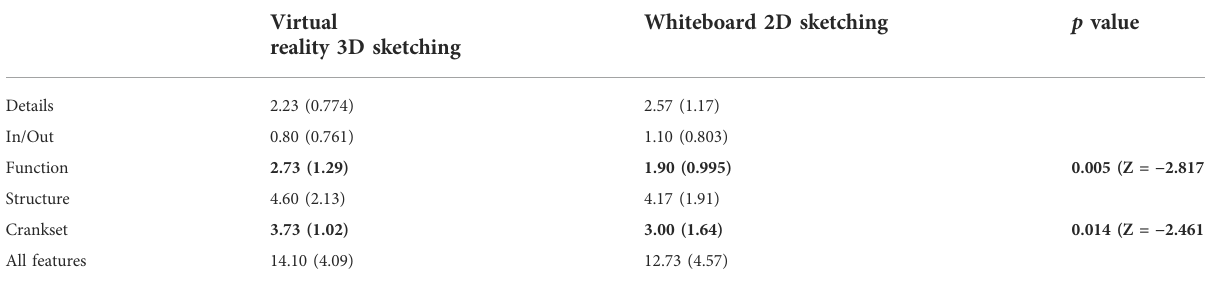
TABLE5Meansandstandarddeviations(betweenbrackets)forthenumberoffeaturesforthesecondphaseofthecreativitytask,concerningthetwo